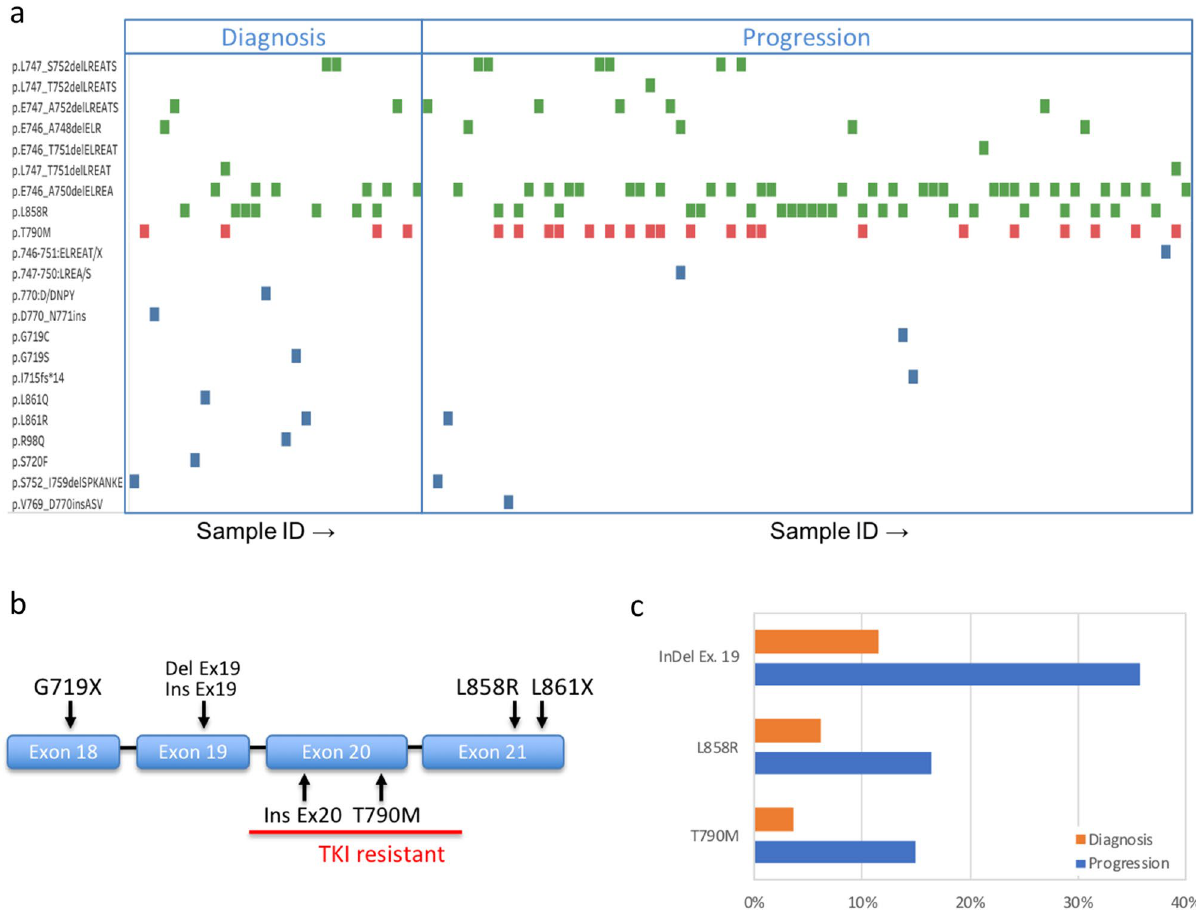
Figure 7. ( a ) Tyrosine kinase inhibitor (TKI) sensitivity and resistance mutations of the EGFR gene detected at diagnosis or at progression. Each symbol represents the detection of a specific variant (y axis) in one patient sample (x axis). Both resistance (red) and sensitivity (green) variants are detected, with all of the 6 types of TKI- relevant variants ( b ) present in the data. The prevalence of three common variant types by time point ( c )